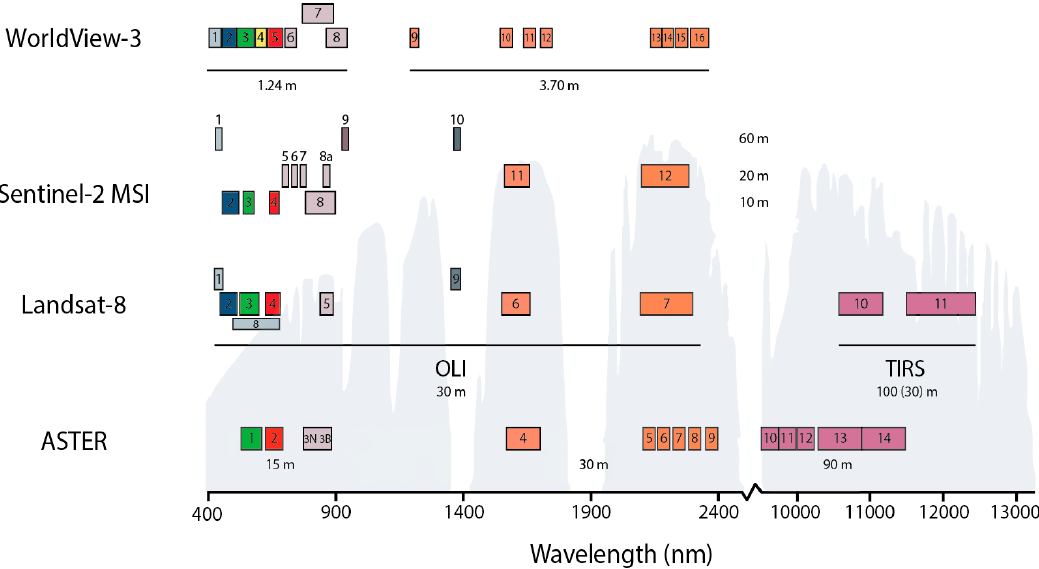
Figure 4. Comparison between ASTER, Landsat 8, Sentinel-2, and WorldView-3 bands. Adapted from USGS Landsat Program [100]. ASTER [81]: 1 green; 2 red; 3N/3B—NIR nadir-looking/NIR backward-looking; 4–9 SWIR; 10–14 TIR. Landsat-8 [89]: 1 coastal aerosol; 2 blue; 3 green; 4 red; 5 NIR; 6 SWIR 1; 7 SWIR 2; 8 Panchromatic; 9 cirrus; 10 TIRS 1; 11 TIRS 2. Sentinel-2 [88]: 1 coastal aerosol; 2 blue; 3 green; 4 red; 5, 6, 7, and 9 vegetation red edge; 8 NIR; 10 cirrus; 11 and 12 SWIR. WorldView-3 [99]: 1 coastal; 2 blue; 3 green; 4 yellow; 5 red; 6 red edge; 7 NIR 1; 8 NIR 2; 9–16 SWIR.